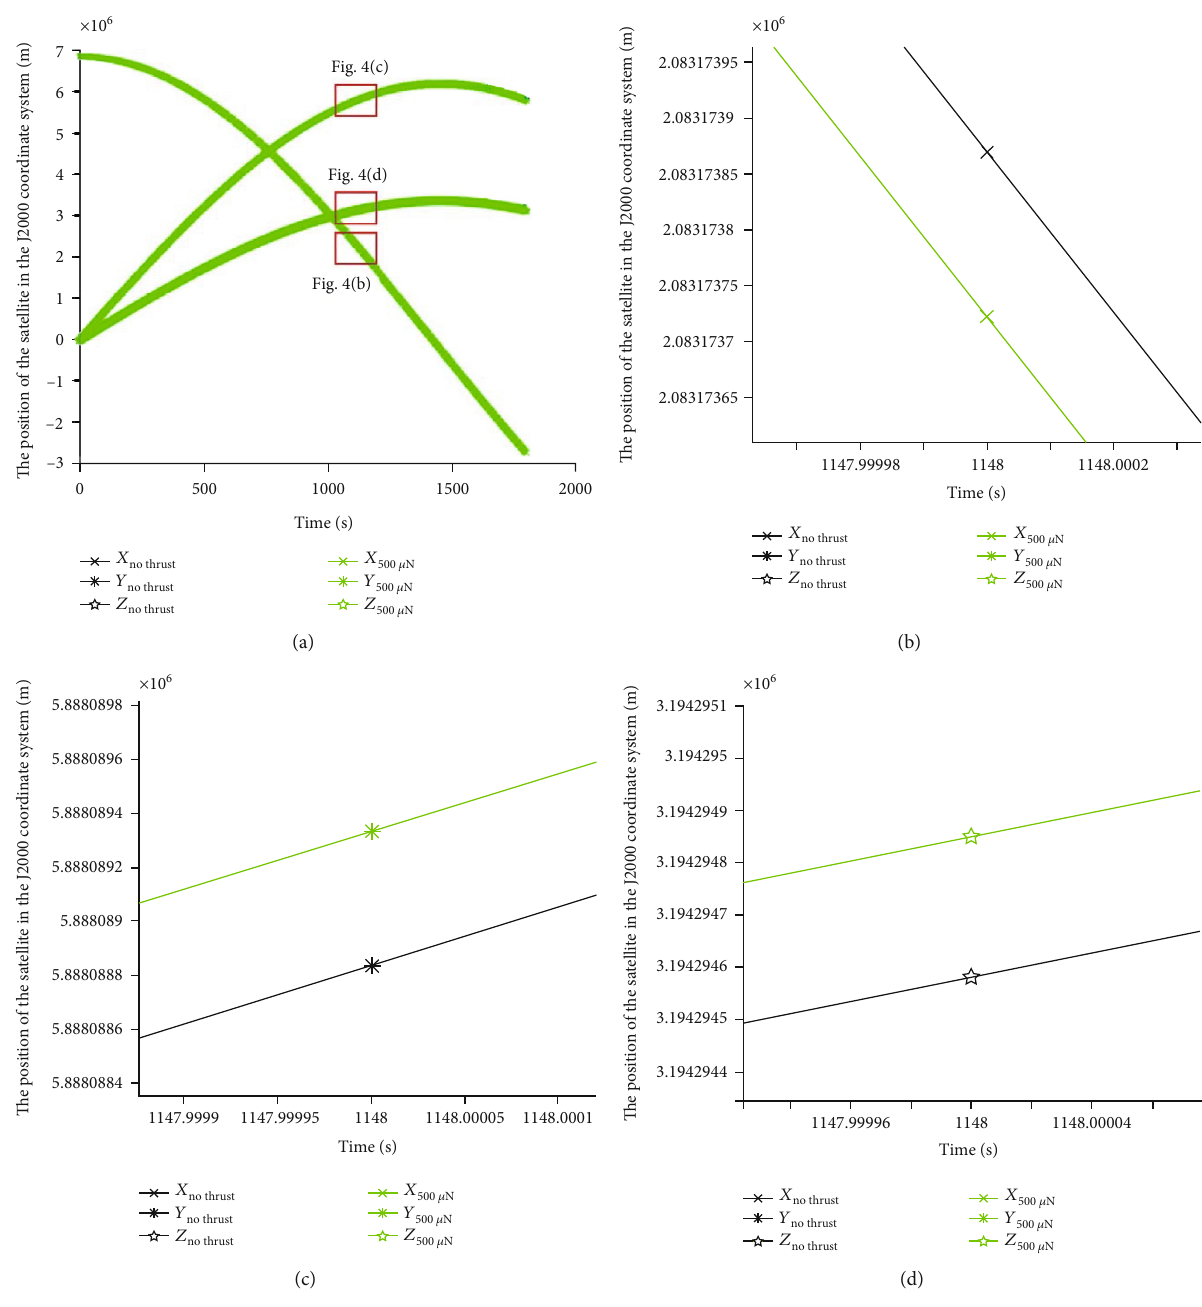
Figure 4: Position of the satellite under the action of 500 μ N According to the simulation results, the average RMSE of the position is 27.58 cm and the average RMSE of the velocity is 53.73 cm/s. The RMSE simulation results of satel- lite three-axis position are shown in Figure 8, in which the average RMSE of the x -axis is 15.92 cm, the average RMSE of y -axis is 15.93 cm, and the average RMSE of z -axis is 15.92 cm. According to the experimental results, it can be found that the orbit determination accuracy of this method can reach decimeter level, which shows that the algorithm has a high accuracy.